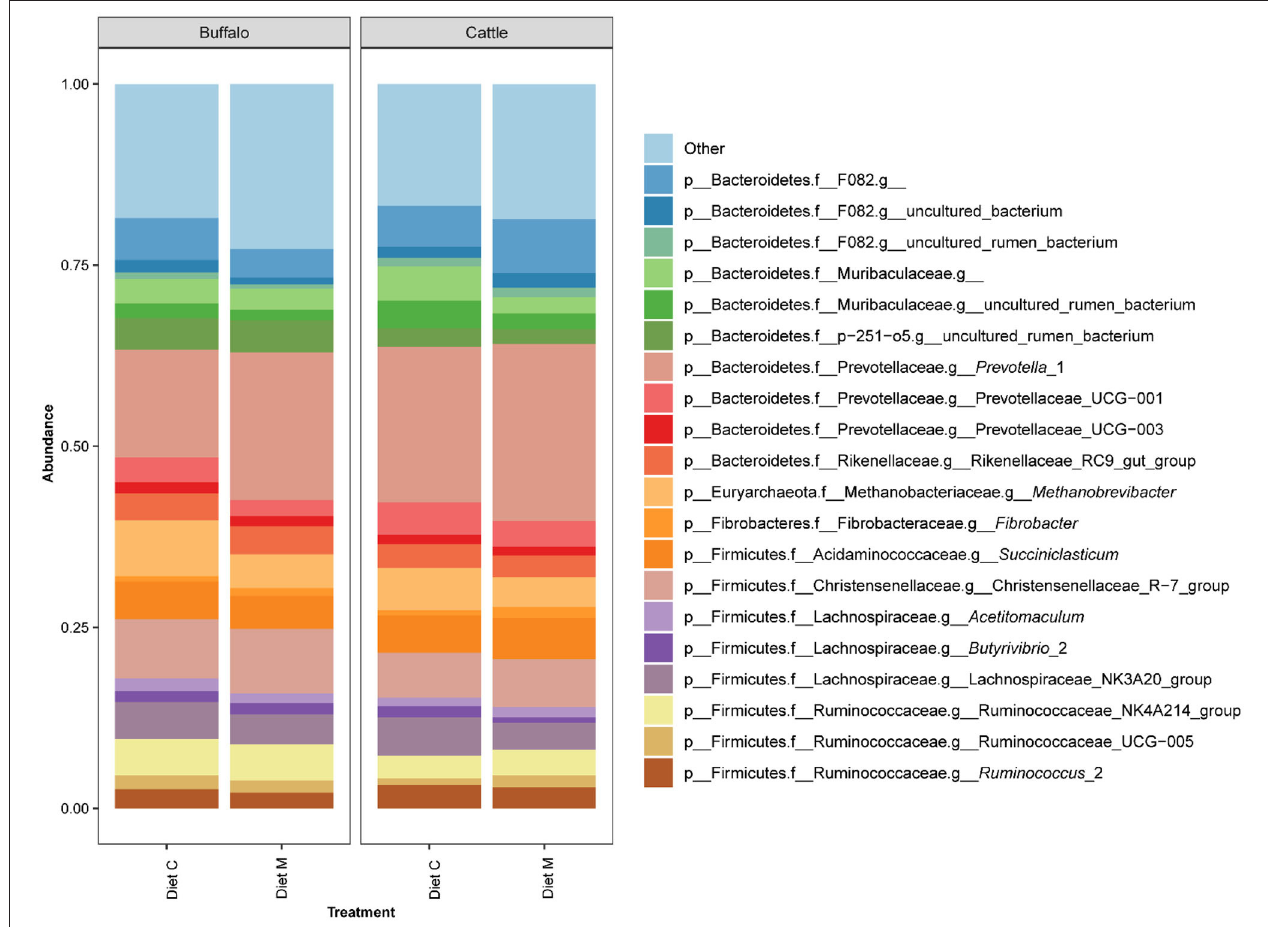
FIGURE 1 | Bar graph showing the average of the 20 most abundant genus level groupings of ASVs from the rumen microbiota of Holstein-Friesian cattle (Cattle) and Mediterranean buffalo (Buffalo) fed diets that differed in terms of containing maize grain which was grown on soil that was treated (Diet M) or not (Diet C) with a commercial AMF